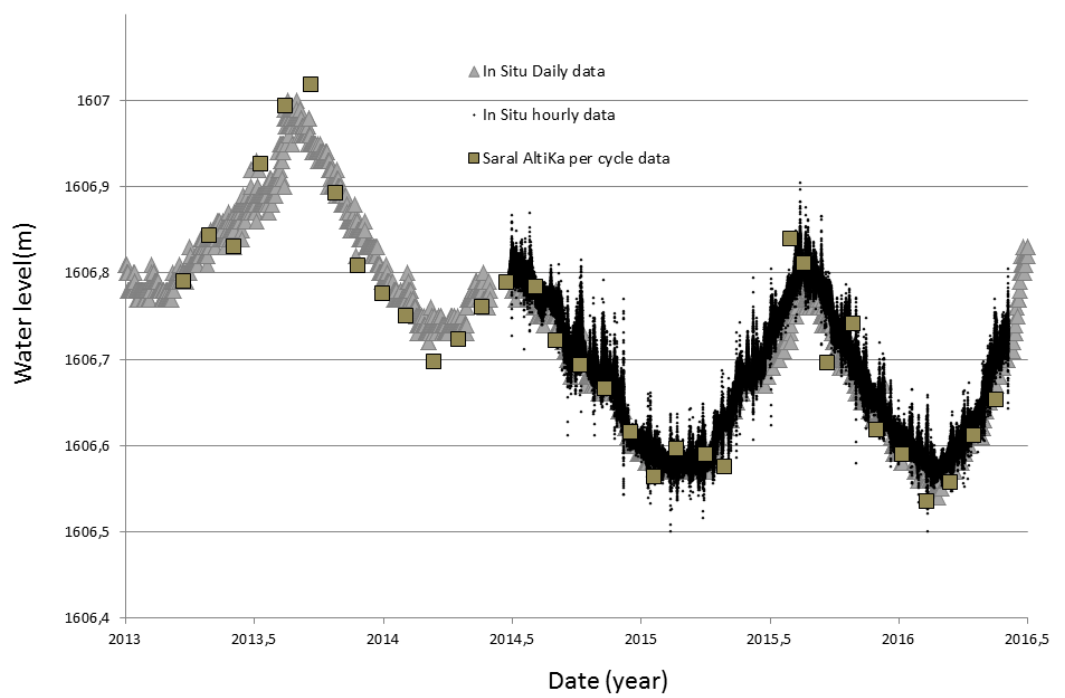
Figure 6. Water level of the lake Issykkul measured by SARAL/AltiKa, a radar and a tide gauge located on respectively east and north coast of the lake, delivering hourly and daily data. RMS of differences between SARAL/AltiKa and the in situ daily data is 3.5